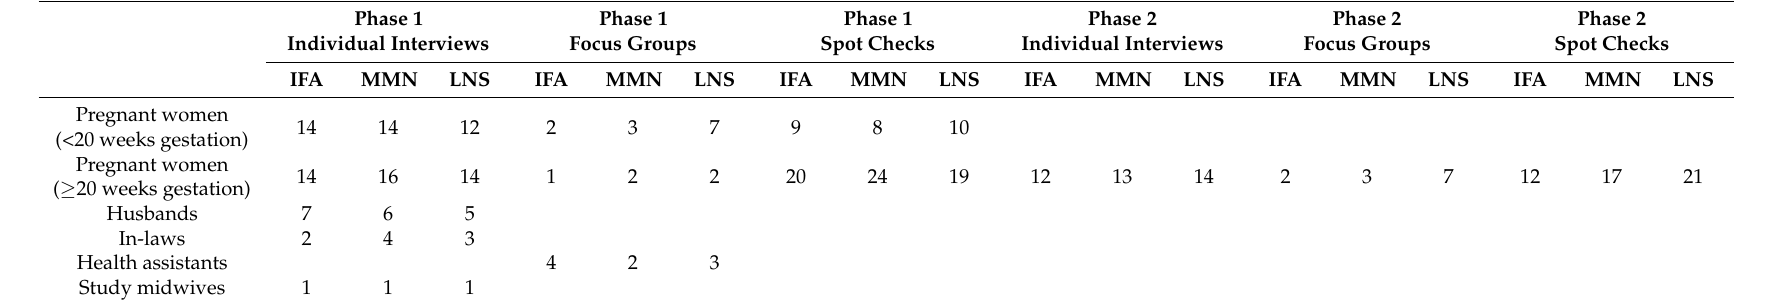
Table 1. Qualitative data collection by participant type, study arm, and